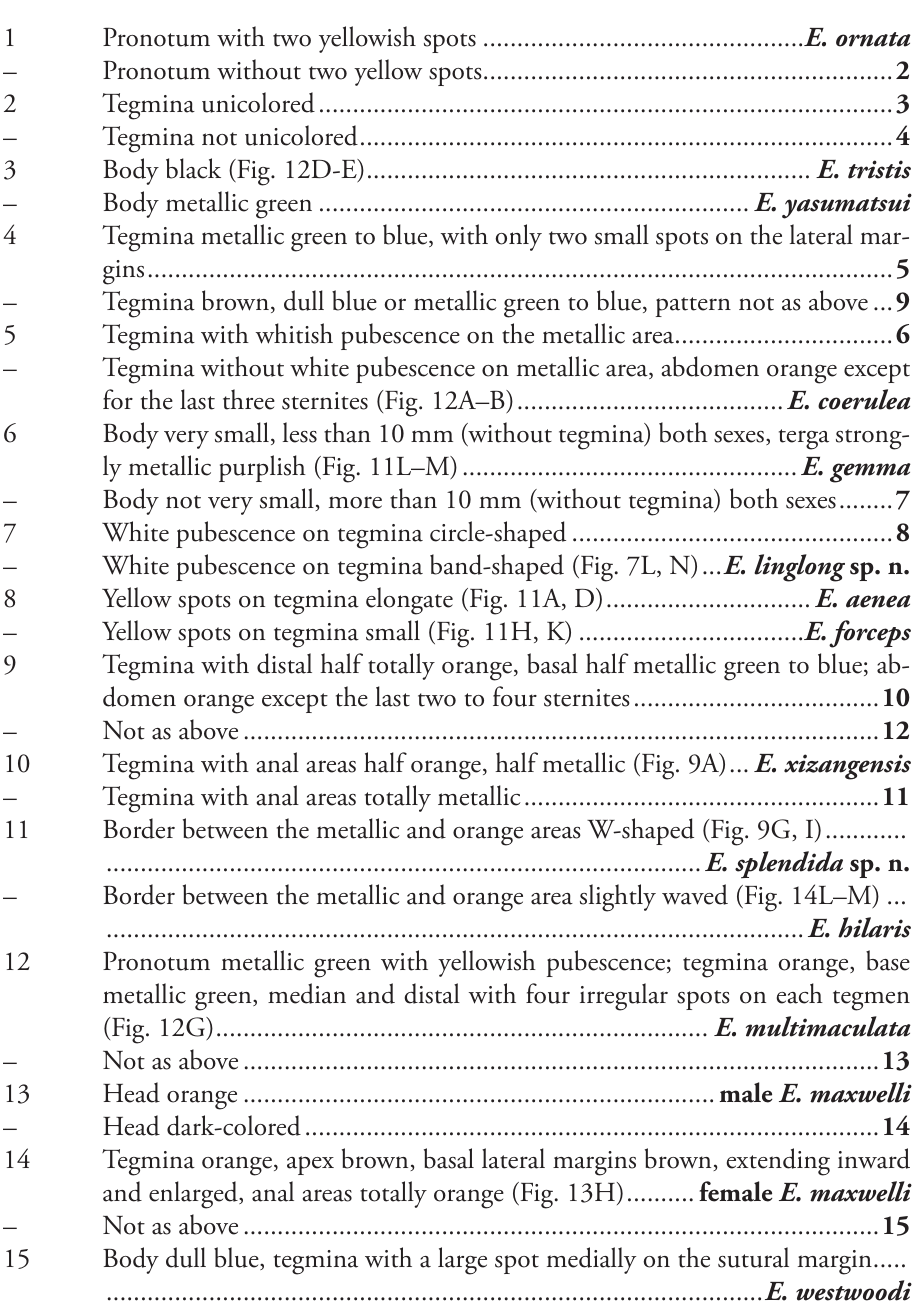
Pronotum metallic green with yellowish pubescence; tegmina orange,